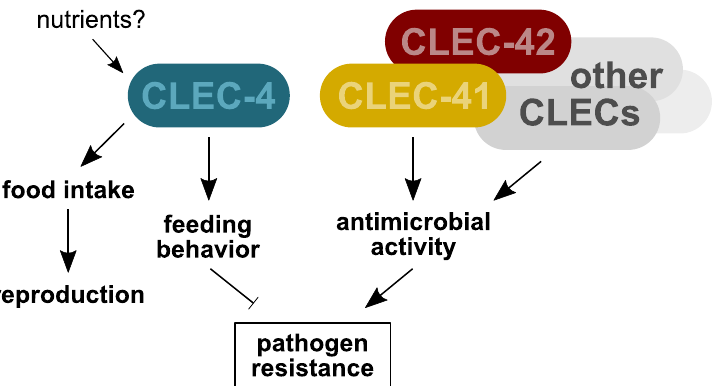
Fig 7. Model of CLEC-4, CLEC-41, and CLEC-42 function. clec-4 is likely to regulate feeding behavior by controlling food intake and may be involved in sensing bacterial-derived or internal nutrients such as glucose or other glycans. clec-4 -mutation-dependent decrease in bacterial load affects reproductive timing, yet also enhances pathogen resistance. CLEC-41 and CLEC-42 directly affect pathogen resistance through their antimicrobial activity against Bt247. Pathogen resistance might be further supported by other, closely related CLEC proteins, possibly in interaction and/or in a compensatory form with CLEC-41 and CLEC-42. clec-4 function and nutrient sensing (Fig 7). Further, we show that clec-41 and clec-42 are required for resistance against Bt247 infection and demonstrate antimicrobial activity of CLEC-41 and CLEC-42 in vitro (Fig 7). Our work reveals a novel function of C . elegans clec genes in regulating feeding behavior, it defines a role for CLEC-41 and CLEC-42 as bona fide immune effector proteins, and thus, it extends the current knowledge on the functional diver- sification of this large gene family.